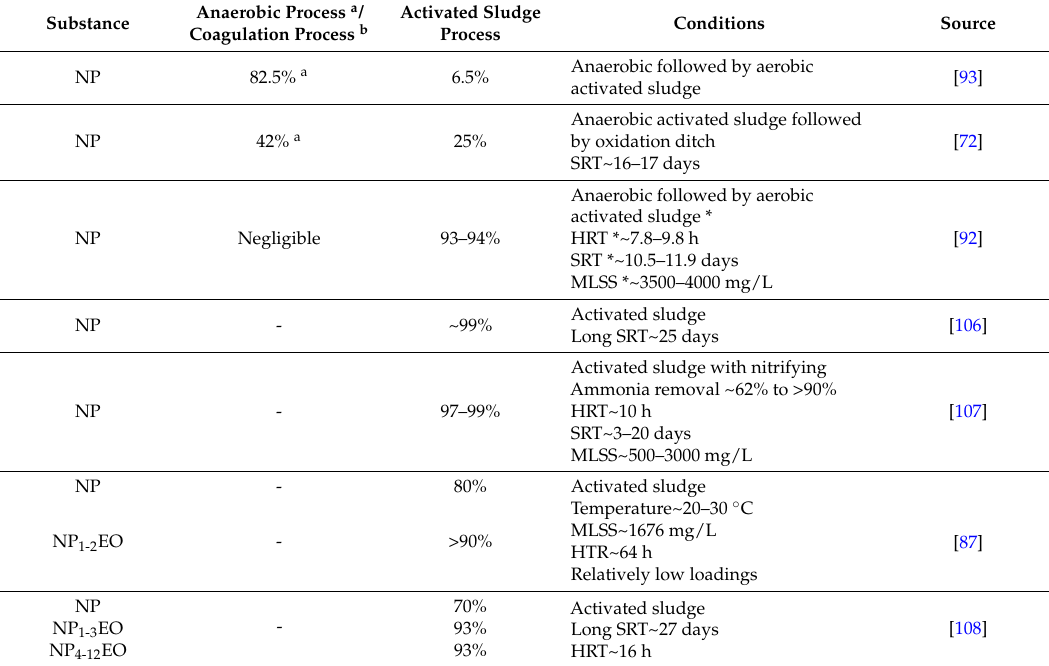
Table 1. Removal efficiency of nonylphenol and nonylphenol